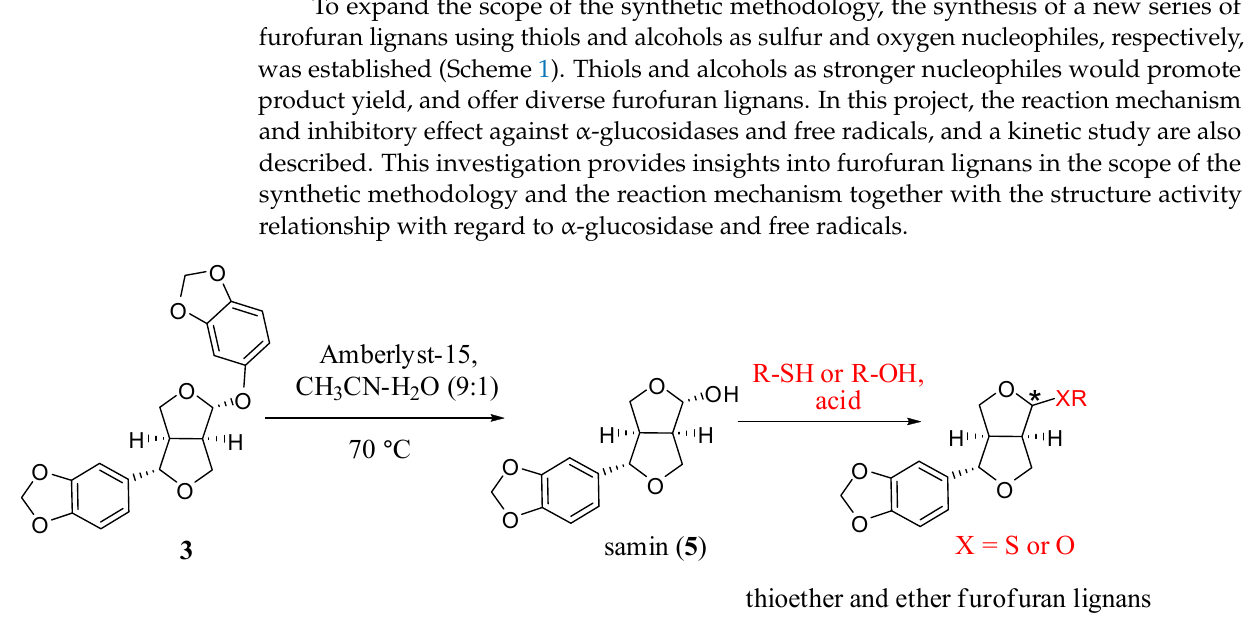
Figure 1. Structures of bioactive furofuran lignans.